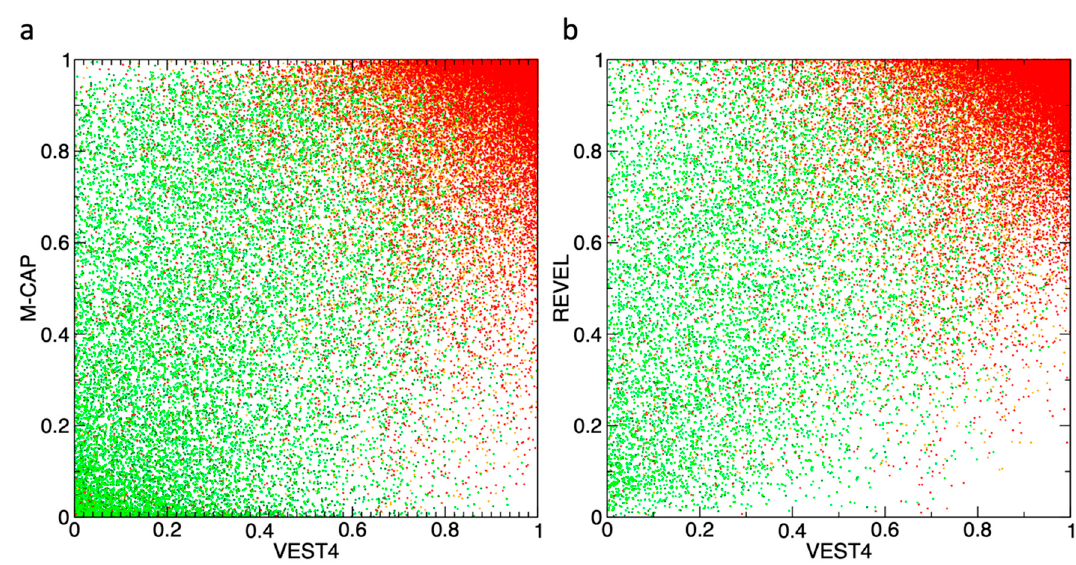
Figure 4. The variants with available ClinVar labels are plotted in two dimensions: x -axis–VEST4 scores, and y -axis–M-CAP ( a ) or REVEL ( b ) scores. The ClinVar classes: ‘ Benign ’ (dark green), ‘ Likely_benign ’ (green), ‘ Likely_pathogenic ’ (orange), and ‘ Pathogenic ’ (red).